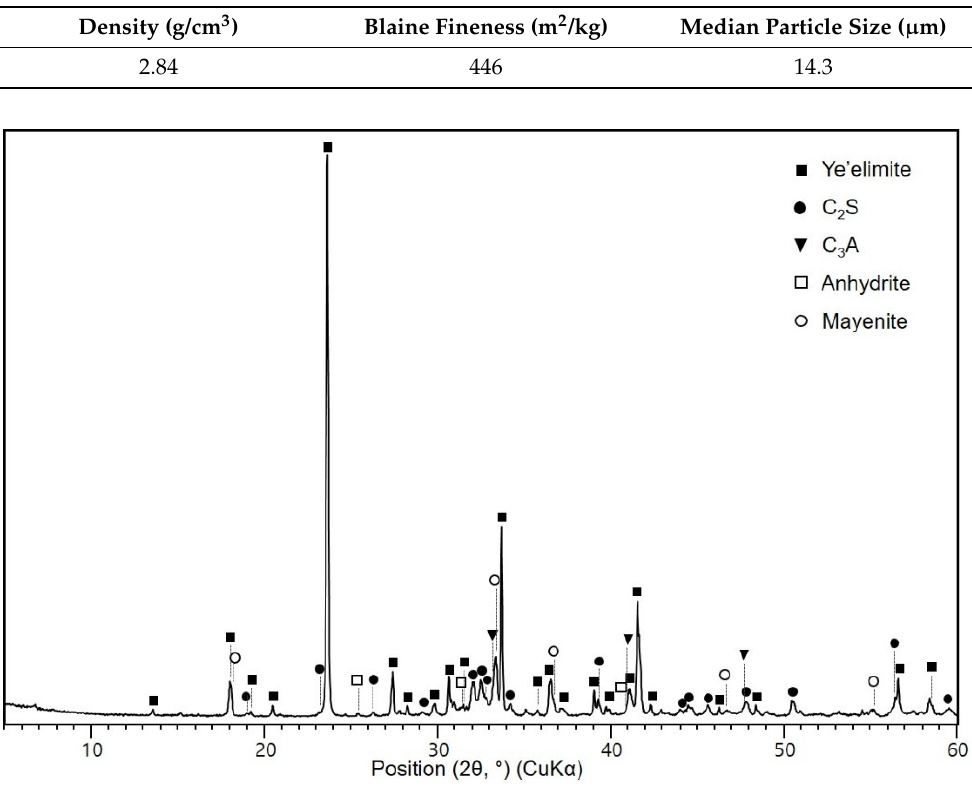
Figure 1. Particle size distribution of CSA cement. Table 2. Physical properties of CSA cement.